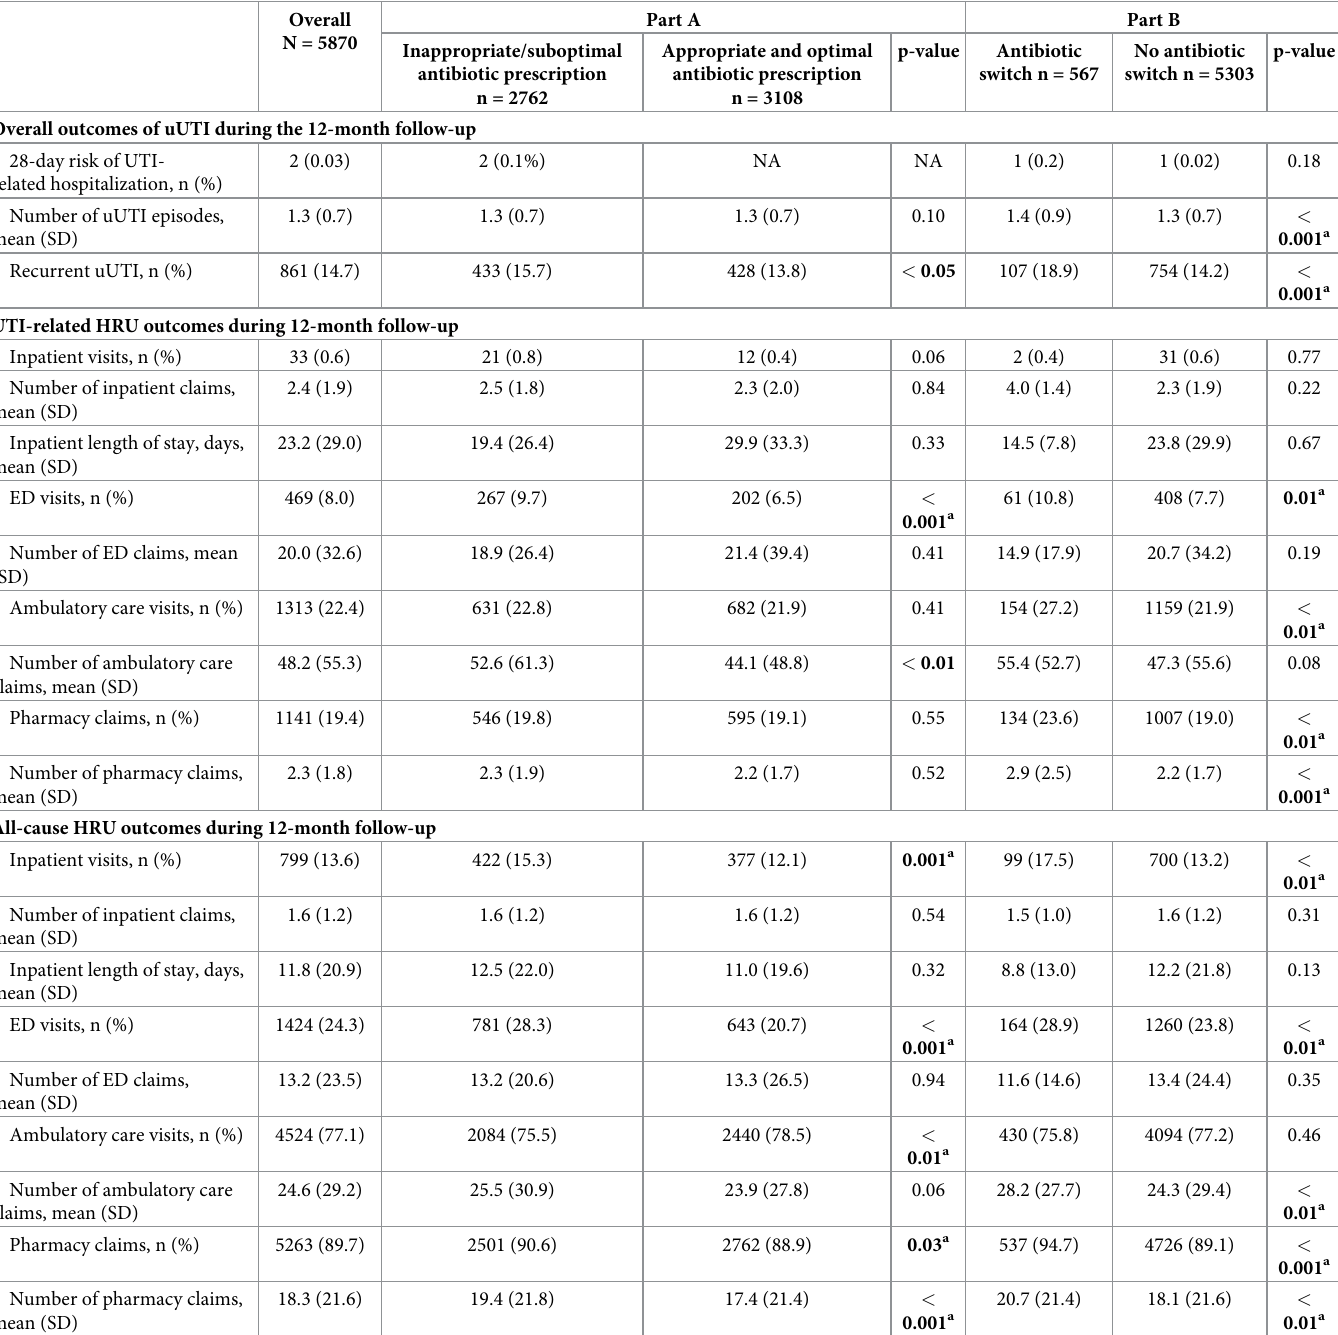
Table 3. Overall, UTI-related, and all-cause HRU outcomes of uUTI outpatients stratified by inappropriate/suboptimal antibiotic prescription (Part A) and antibi- otic switching (Part B) during 12-month follow-up. Overall Part A Part B N = 5870 n =